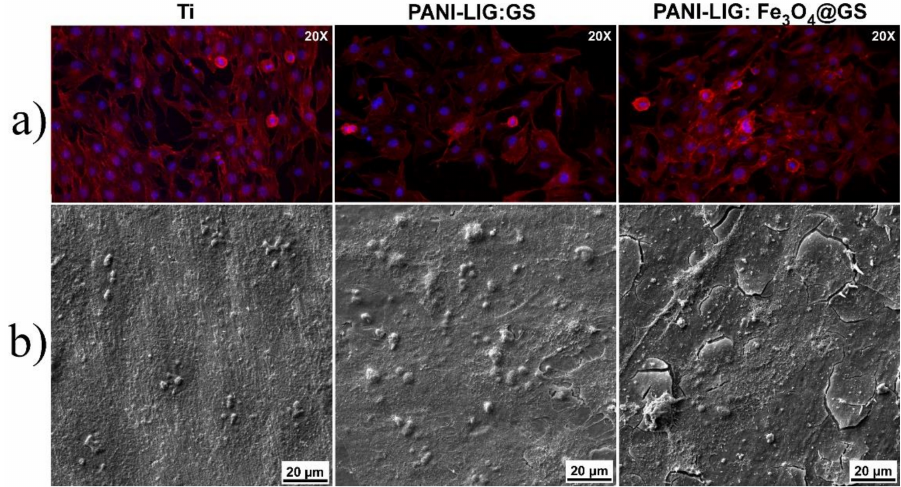
Figure 8. MG-63 cells fluorescence microscopy for substrate and PANI-LIG:GS and PANI-LIG:Fe 3 O 4 @GS coatings, respectively. (red Phalloidin and Hoechst staining) ( a ) and SEM images of MG-63 cells treated in the presence for substrate and PANI-LIG:GS and PANI-LIG:Fe 3 O 4 @GS coatings at 48 h of incubation ( b ). (For interpretation of the references to color in this Figure legend, the reader is referred to the web version of this